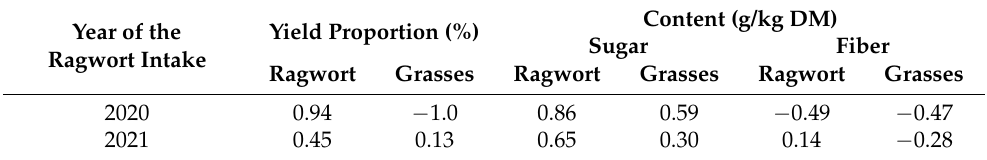
Table 4. Matrix of ragwort intake and selected